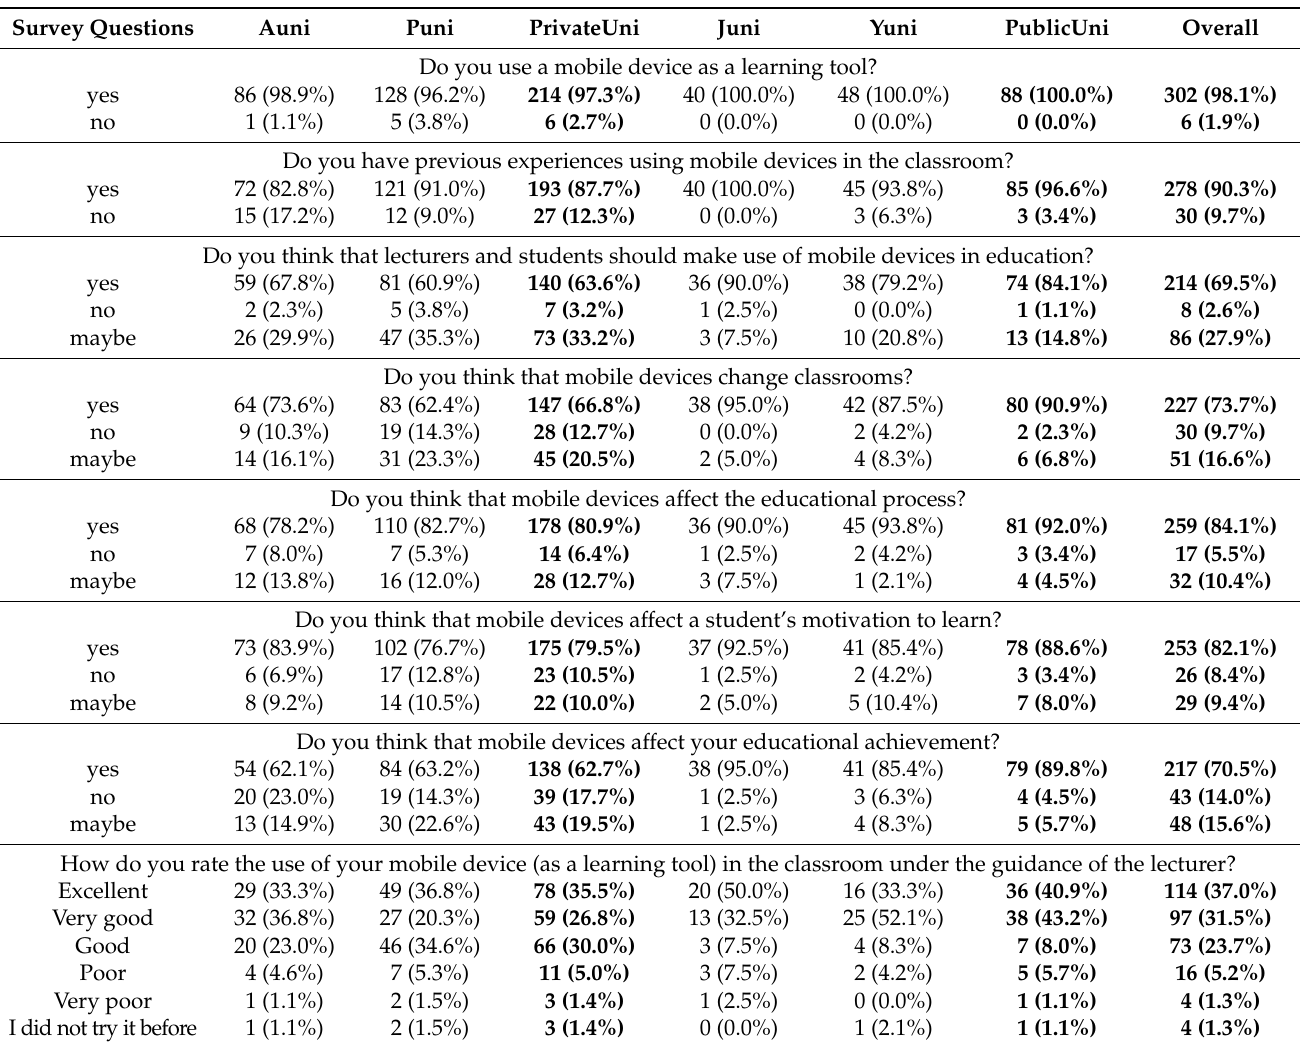
Table 4. Students’ perception of mobile